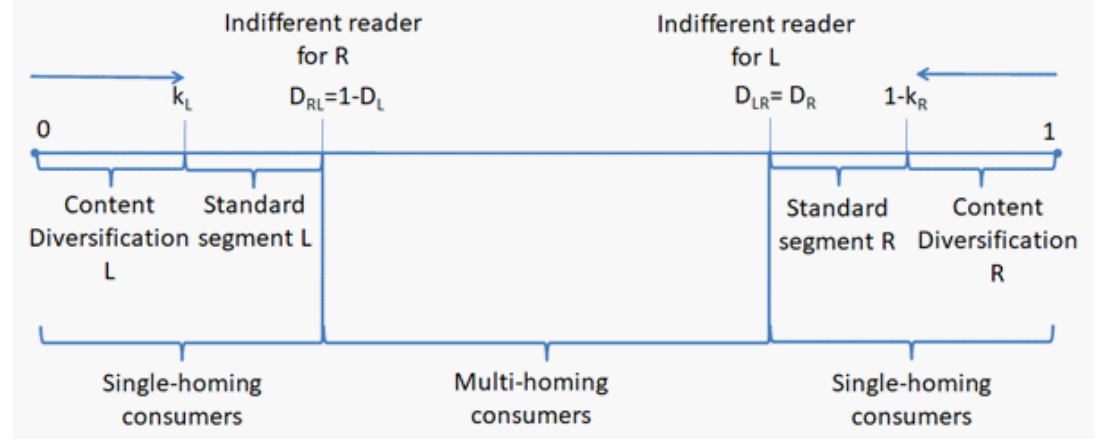
Figure 2: Content Diversi(cid:133)cation: Multi-Homing Figure 2. Content Diversification: